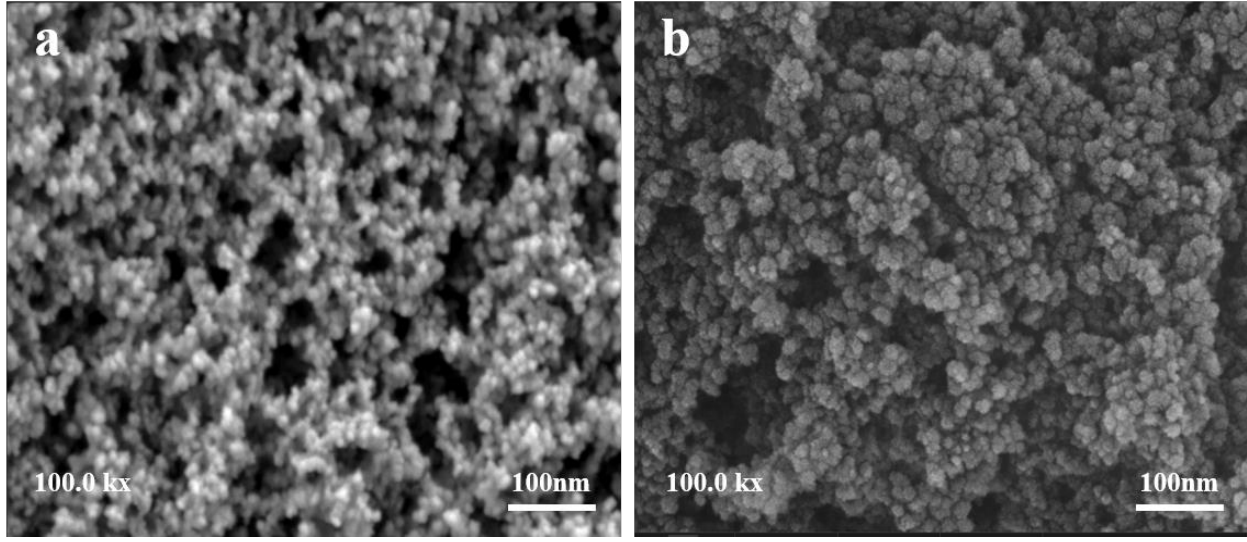
Figure 5. SEM images of SiO 2 ( a ) and composite PCMs ( b ). The FT-IR spectrum of SiO 2 , DHPT, DHPD, and composite PCMs is presented in Figure 6. For the spectra of composite PCMs (CPCM), the characteristic absorption peaks at 1096 cm − 1 and 4667 cm − 1 correspond to the antisymmetric stretching vibration and bending vibration of Si-O-Si, respectively. The absorption peak at 1096 cm − 1 was also the stretching vibration peak of HPO 42 − . In addition, the stretching vibration peak of HPO 42 − also appeared at 859 cm − 1 and 544 cm − 1 . Only the characteristic absorption peaks of HPO 42 − and SiO 2 appeared in the composite PCMs, and no other peaks appeared. The results indicated no chemical reaction between eutectic hydrated salt and SiO 2 , but only physical